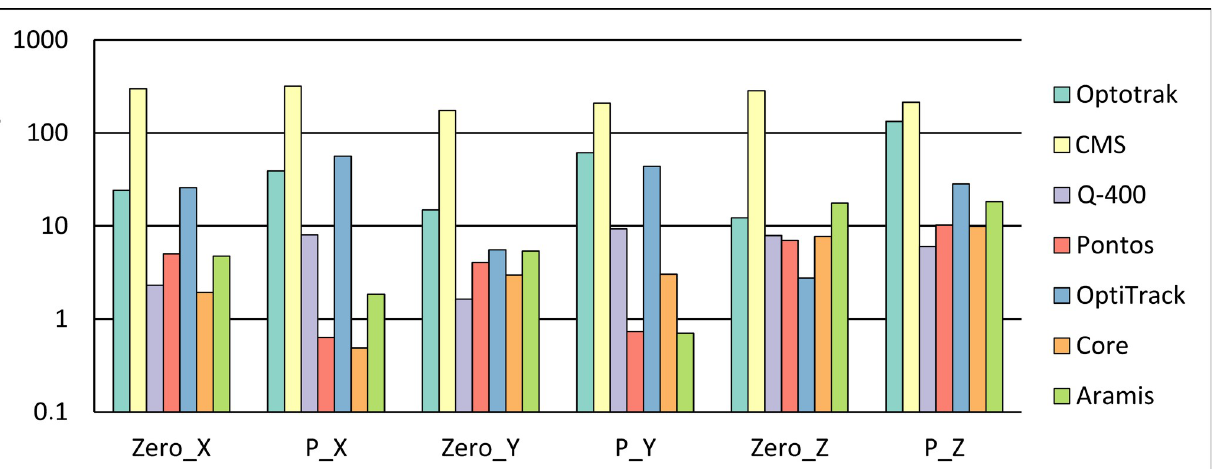
PLOS ONE | https://doi.org/10.1371/journal.pone.0271349 July 11,